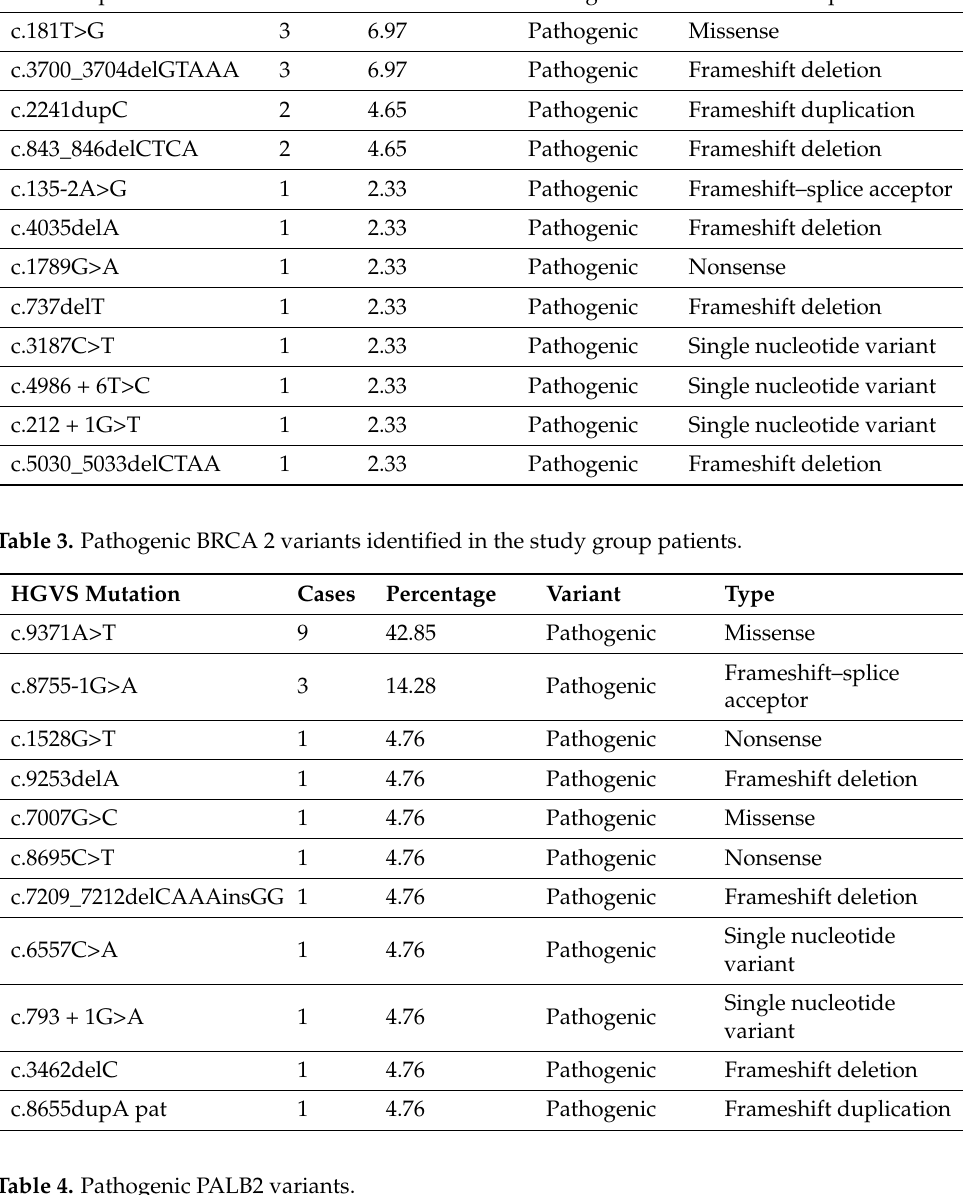
Table 4. Pathogenic PALB2